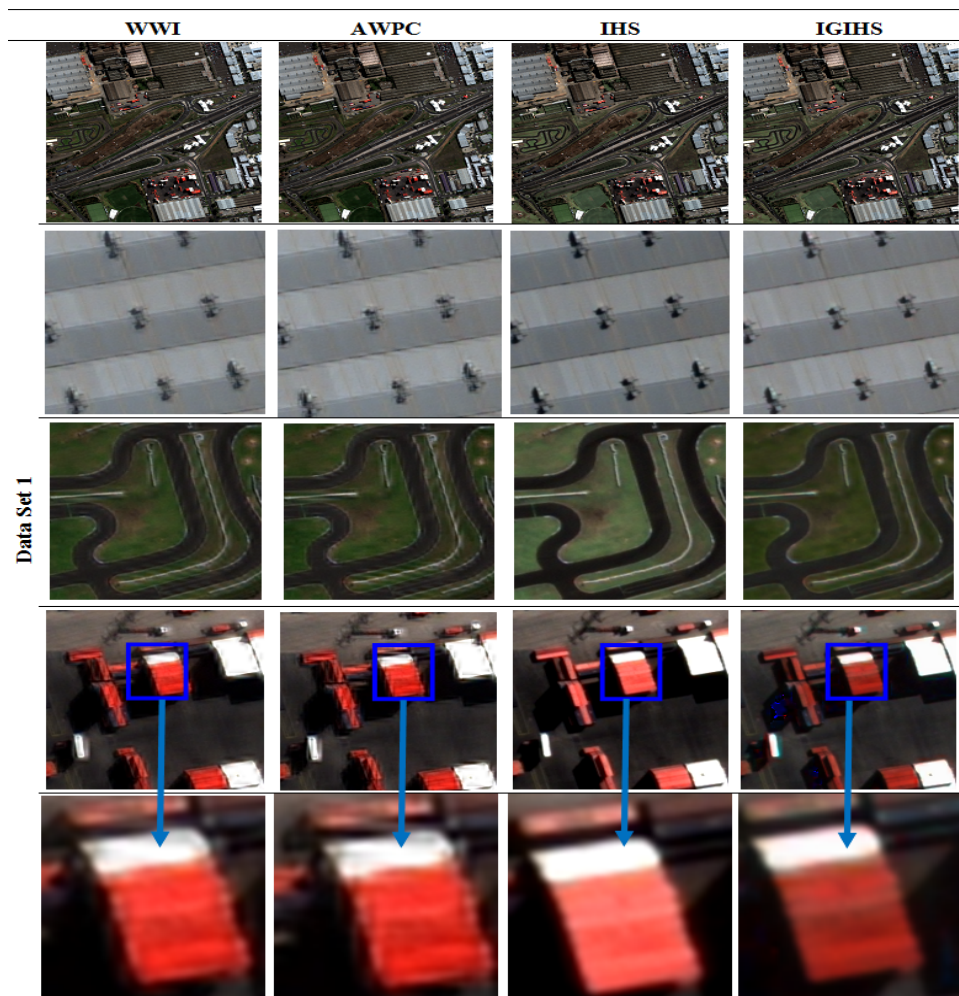
Figure 4. Pan-sharpening results, data set